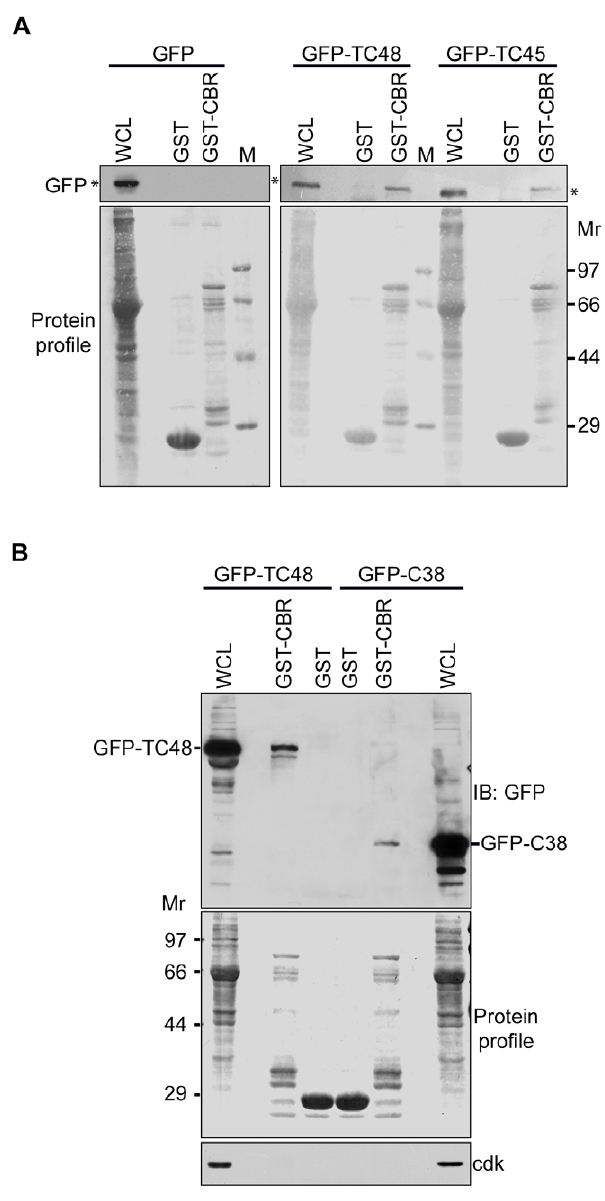
Figure 2. C-terminal residues of TC-PTP are responsible for direct interaction with CBR domain of C3G. (A) In vitro interaction between C3G and TC-PTP. GST and GST-CBR coupled to glutathione agarose beads were incubated with lysates of HEK-293 cells expressing GFP, GFP-TC45 or GFP-TC48. The WCL and washed beads were subjected to western blotting for GFP. The recombinant protein levels are shown in the Ponceau stained blot. M, protein molecular weight markers. * indicates position of GFP and the GFP fusion proteins. (B) C3G Crk binding region interacts with C-terminal regulatory sequences of TC-PTP. TC48 and a deletion construct of TC45, GFP-C38 (schematic shown in